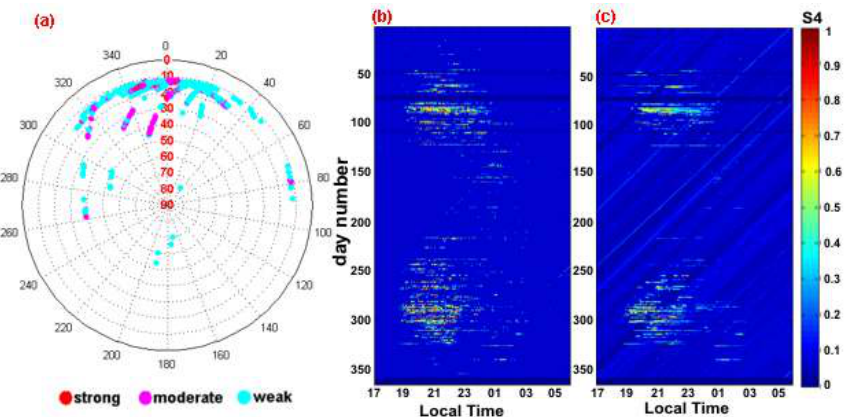
Fig. 13. (a) A directional plot for post-midnight scintillations in the non-plasma-bubble season observed at Bandung in 2011 and comparison between the scintillation occurrences at Bandung in 2001 with (b) the sigma-CCDiv filter with data at elevation angles down to 10 ◦ and (c) Figure 13. (a) Directional plot for post-midnight scintillations in non-plasma bubble season 3 the traditional 30 ◦ elevation mask that are observed at Bandung in 2011, and comparison between the scintillation occurrences 4 at Bandung in 2001 with (b) the sigma-CCDiv filter down to 10 degrees of elevation angles 5 and (c) the traditional 30 degrees elevation mask only. 6